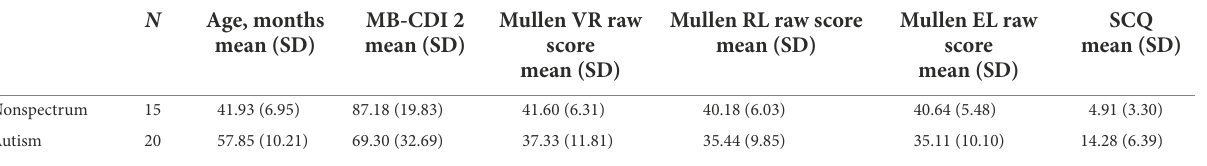
TABLE 1 Children’s language and cognition scores on standard assessments.